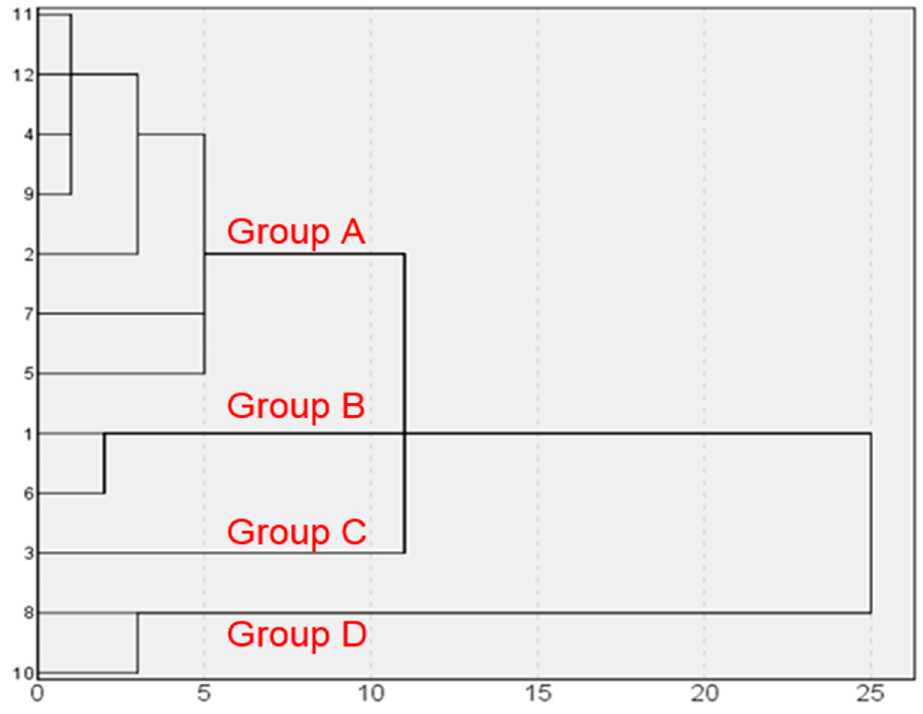
Figure 8. Results of Hierarchical Cluster Analysis of twelve samples.